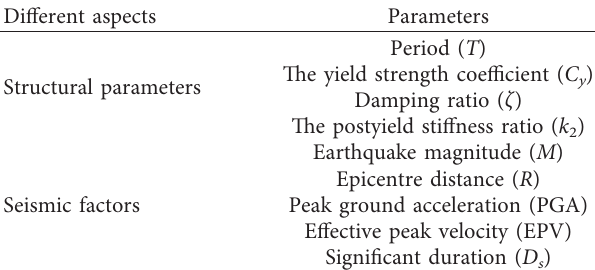
Figure 1: Data distribution of the selected ground motion records. Table 1: Influencing factors and